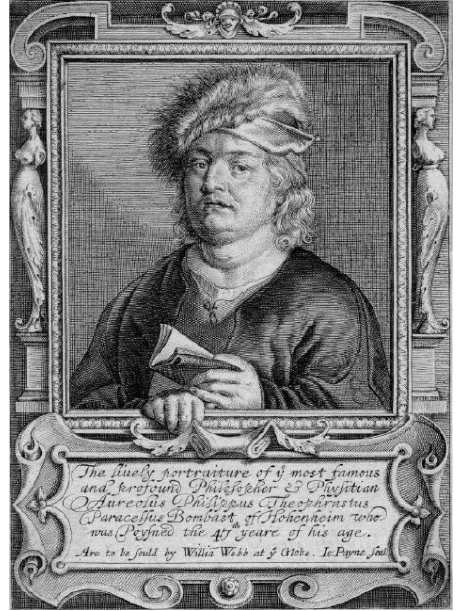
Figure 6. Philippus Aureolus Theophrastus Bombastus von